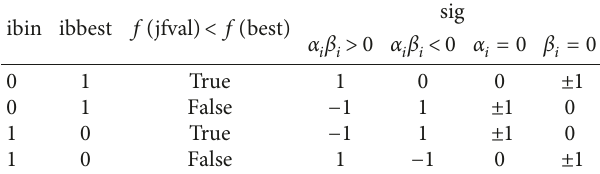
Figure 1: Code in quantum bit encoding.